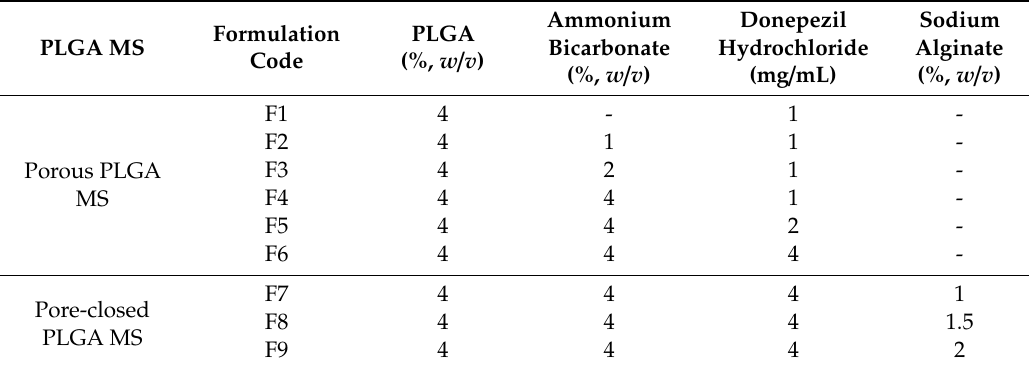
Table 1. Preparation conditions of porous poly(lactic- co -glycolic acid) (PLGA) microspheres (MS) and pore-closed PLGA MS.